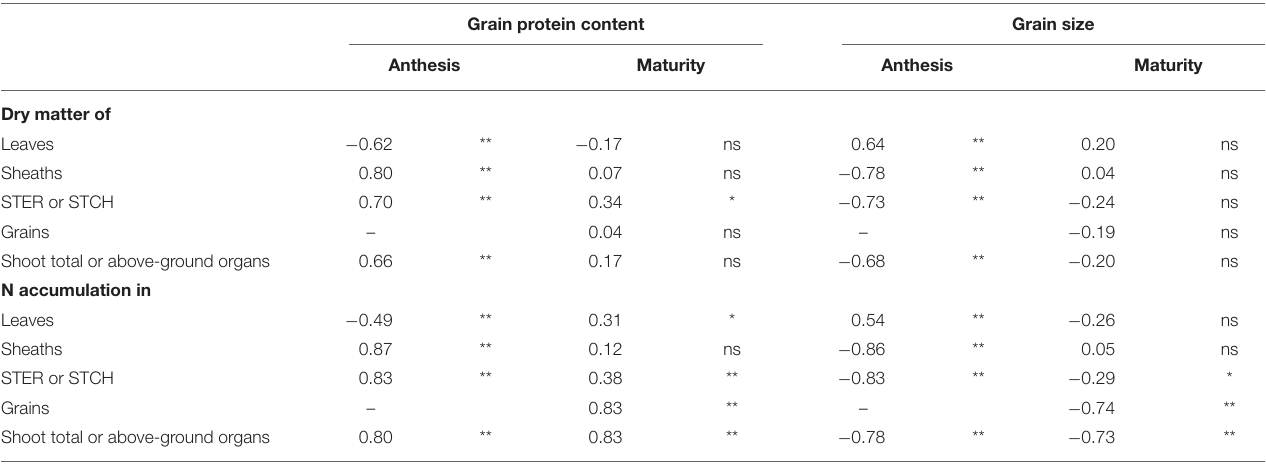
TABLE 4 | Pearson’s correlation coefficient of grain protein content and grain size with DM and N accumulation in leaves, sheaths, STER or STCH, and total aboveground organs at anthesis and maturity and grain yield among the 23 spring malting barley varieties under the recommended N fertilization conditions across 2 years.